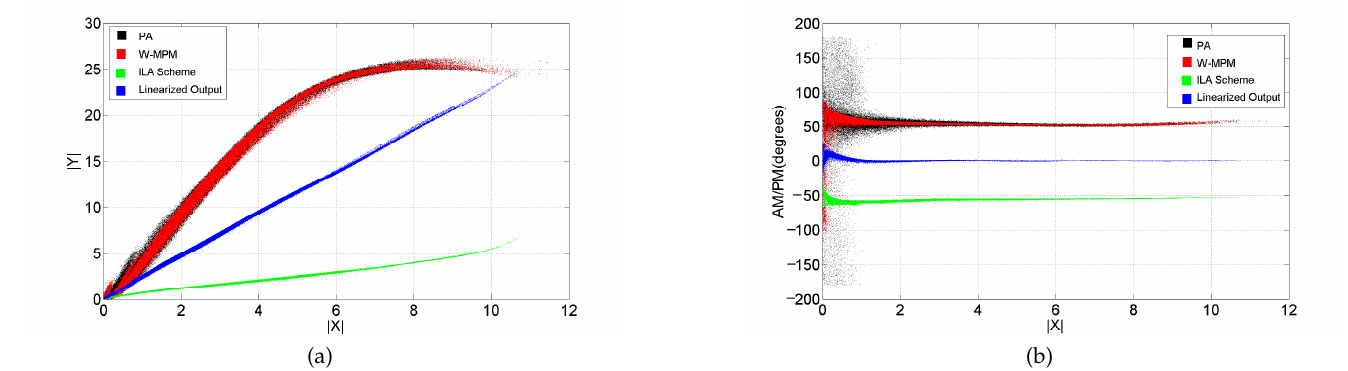
Figure 6. Linearization based on ILA based on W-MPM for the device ZHL-42W+ at 2000 MHz 32.24 dBm RF-PA. ( a ) AM/AM modeling and linearization stage and ( b ) AM/PM modeling and linearization